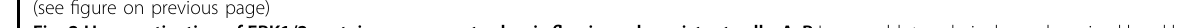
Fig. 2 Hyperactivation of ERK1/2 sustains proper autophagic fl ux in early resistant cells. A , B Immunoblot analysis showed maximal basal level of phospho-ERK1/2, p90 RSK1/2 , and FRA-1 in A2780Dual ER and OAW42Dual ER cells compared to sensitive and late resistant cells of both A2780 and OAW42 model, while the basal level of AKT phosphorylation was highest in A2780Dual LR and OAW42Dual LR cells. C , D Cell survival assay signifying an additive cytotoxic effect of CisPac + U0126 over CisPac (IC50 dosage) and U0126 alone in A2780Dual ER (26.15%) and OAW42Dual ER (23.28%) cells, E , F Immunoblot depicting increased LC3 conversion and p62 accumulation in CisPac + CQ-treated A2780Dual ER cells in comparison to cells treated with only CisPac, while application of CQ along with CisPac + U0126 or CisPac + Trametinib (Tranib) did not alter LC3 conversion or p62 level in comparison to cells treated with CisPac + U0126 or CisPac + Trametinib. G Increased LC3I – II conversion and p62 accumulation was observed in A2780Dual ER/ERK1 cells compared to the parental cells post 24 h of CisPac treatment. H Immunoblot depicting LC3I – II conversion and p62 accumulation in sensitive and late resistant A2780 and OAW42 cells treated with platinum – taxol alone or in combination of U0126. I , K Representative electron microscopy images of A2780Dual ER and OAW42Dual ER cells treated with CisPac alone or in combination of U0126 depicting individual autophagic structures phagophore (red arrow), autophagosome (green arrow), and autophagolysosome (yellow arrow), J , L Graphical representation of total and individual number of autophagic structures revealed increased number of phagophores (1.67- and 1.44-fold) and autophagosomes (2.1- and 2-fold) with a concomitant reduction (0.6- and 0.5-fold) in autophagolysosomes in A2780Dual ER and OAW42Dual ER cells post combinatorial treatment of CisPac and U0126 in comparison to only CisPac ( n = 10 cells/group, data represent mean ± SEM of at least two independent experiments, ns indicates nonsigni fi cant, * p < 0.05, ** p < 0.005, *** p < 0.0005 as calculated by unpaired t